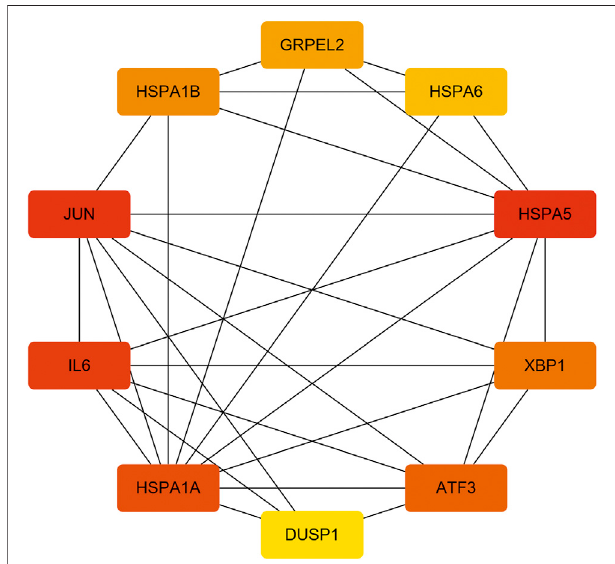
FIGURE 6 | The 10 hub genes interaction network. Each node indicates a gene, and each edge between the two nodes indicates a possible interrelationshipofthosetwogenes.Thecolorgradientofthenodere fl ectsthe MCC score, and the darker the color, the higher the score.